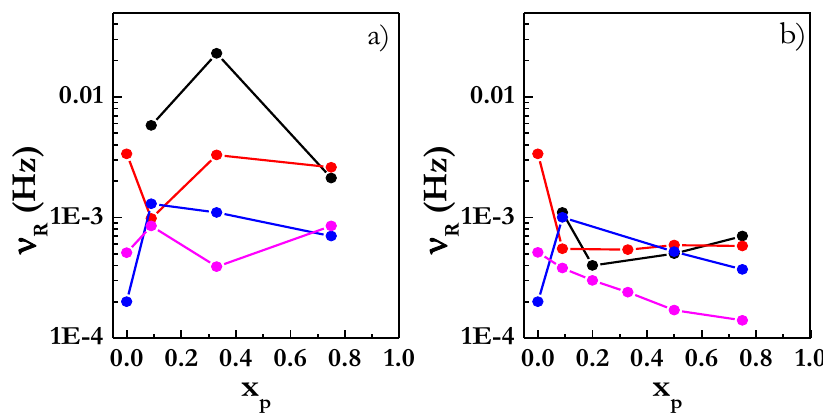
Figure 9. ν R dependences, obtained using Equation (4), on the particle weight fraction, x p , for different values of the surface pressure Π for DPPC monolayers upon incorporation of CB ( a ) and SiO 2 ( b ): ( ―●― ) 3 mN/m, ( ―●― ) 7.5 mN/m, ( ―●― ) 20 mN/m and (―●―) 40 mN/m. Notice that the lines are guides for the eyes.